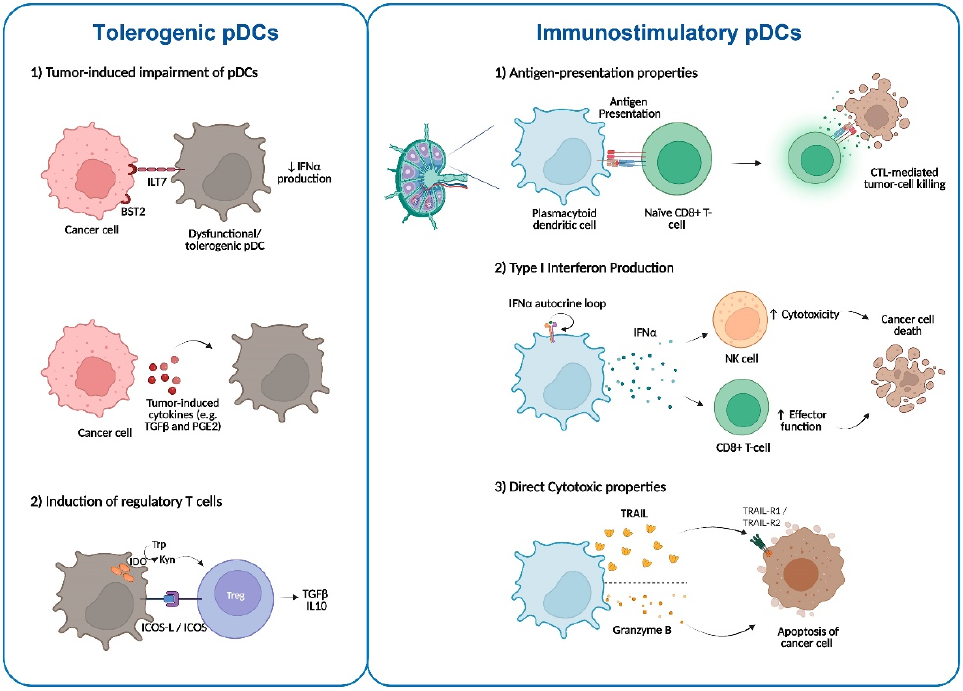
Figure 1. Plasmacytoid dendritic cells play a dual regulatory role in cancer immune responses. pDCs that exhibit a tolerogenic phenotype ( left panel ) contribute to the tumor immune escape. At the same time, signals released from tumor cells and the TME (e.g., the expression of BST2 in cancer cells or tumor-derived cytokines) favor the impairment of pDCs. On the other hand, functional pDCs ( right panel ) can trigger anti-tumor immune responses through their antigen-presenting capacity and cytotoxic functions.